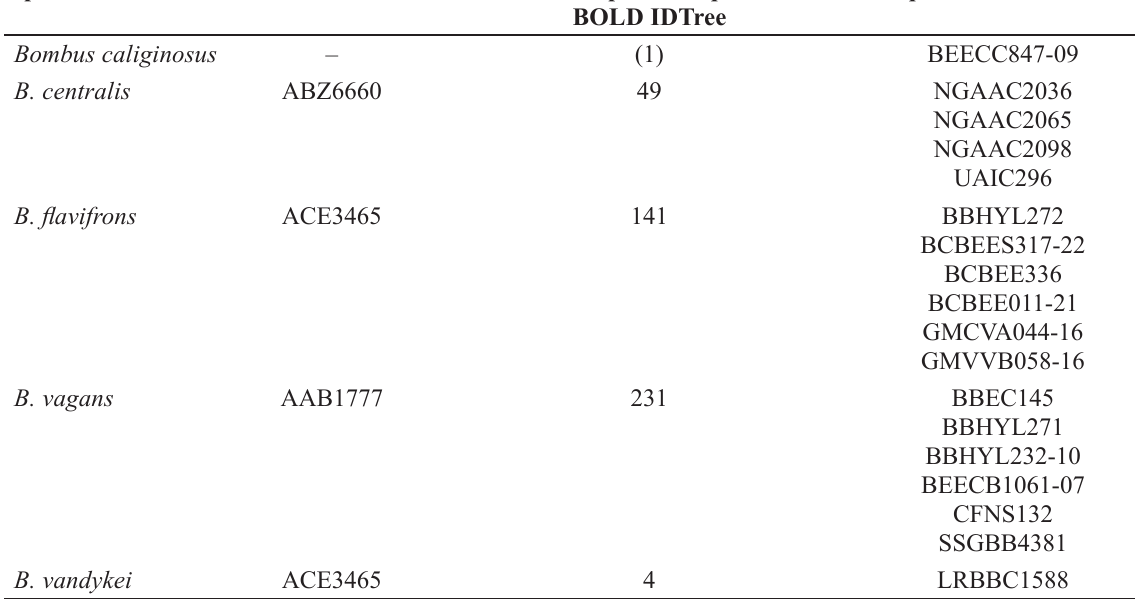
Table 2. List of selected available formal names in the species group for taxa of the Bombus hypnorum - complex (for details of the references, see the text) . These names are associated informally with barcoded specimens as proxies for types. Specimen ID refers to the specimen number (# n ) of the proxy type in the hypnorum- complex project